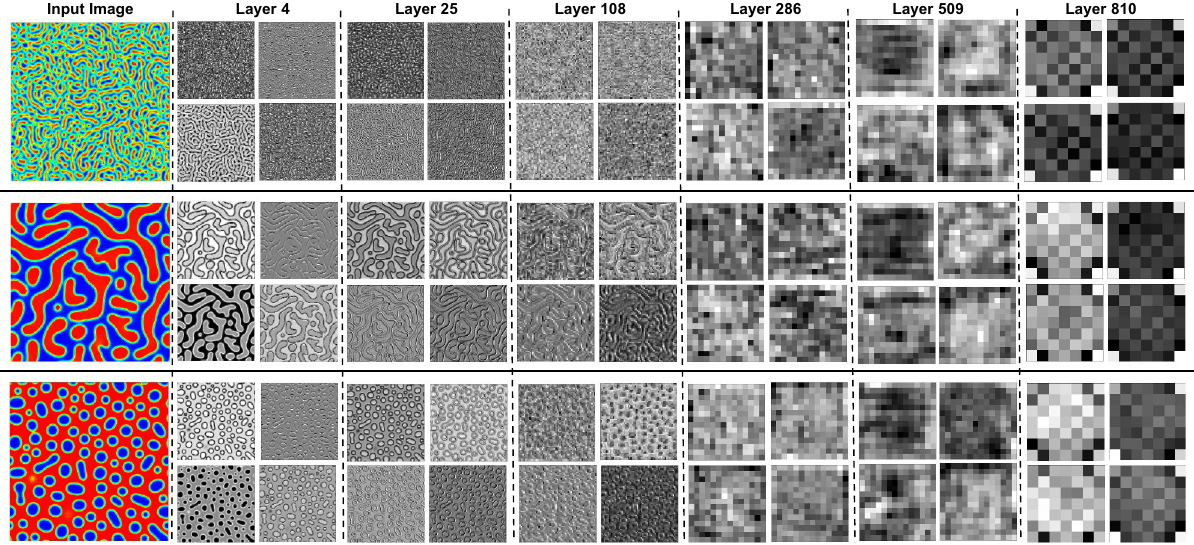
Figure 6. Sample response maps in EfficientNetB7 for 2D microstructure morphology inputs. The response map of the first four filters of some convolutional layers is illustrated for three input images. The layer numbers are presented at the top of the images.